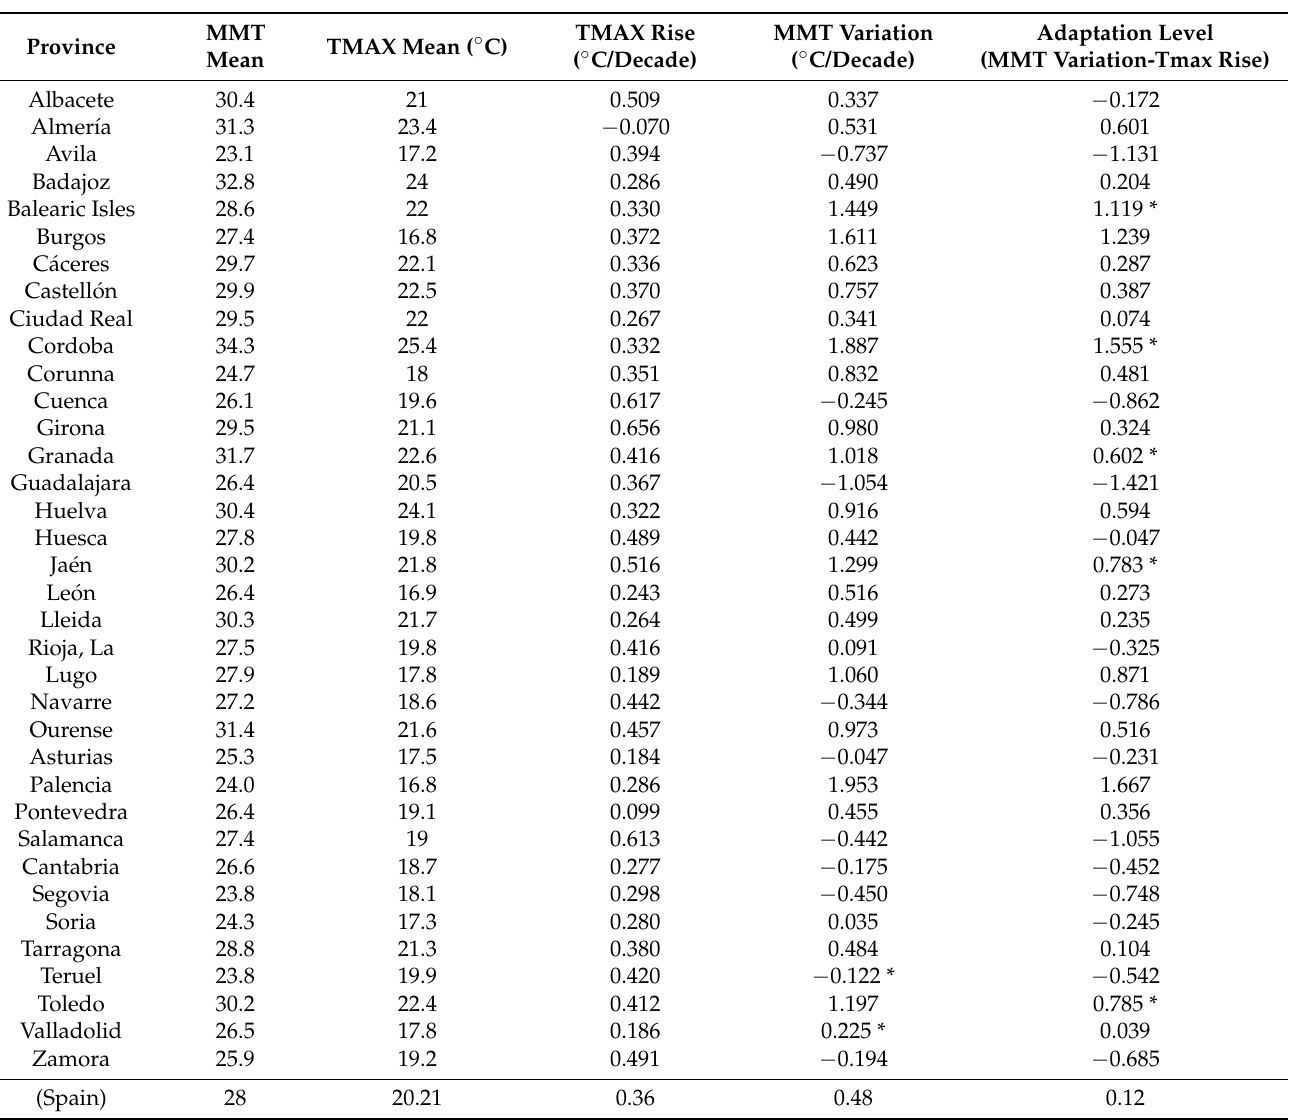
Table 2. Relationship of variables, by nonurban province, between minimum mortality temperature (MMT) in persons aged 65 years or over, MMT mean, TMAX mean, trend by decade in TMAX, variations in MMT, and adaptation levels. * p <